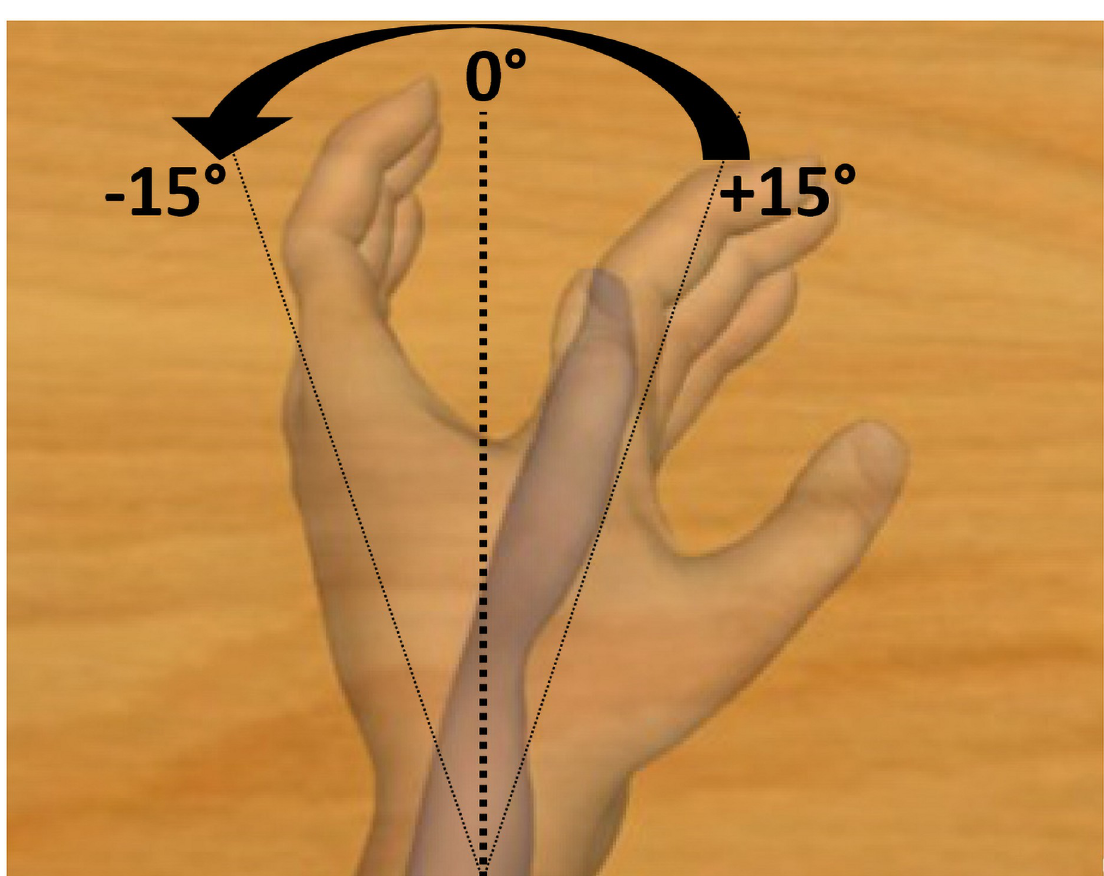
Fig 3. Description of the virtual cue. Virtual movements from wrist flexion to wrist extension, with a total displacement of 30 degrees around the resting position. The values and arrows were not visible to the participant during the experiment. https://doi.org/10.1371/